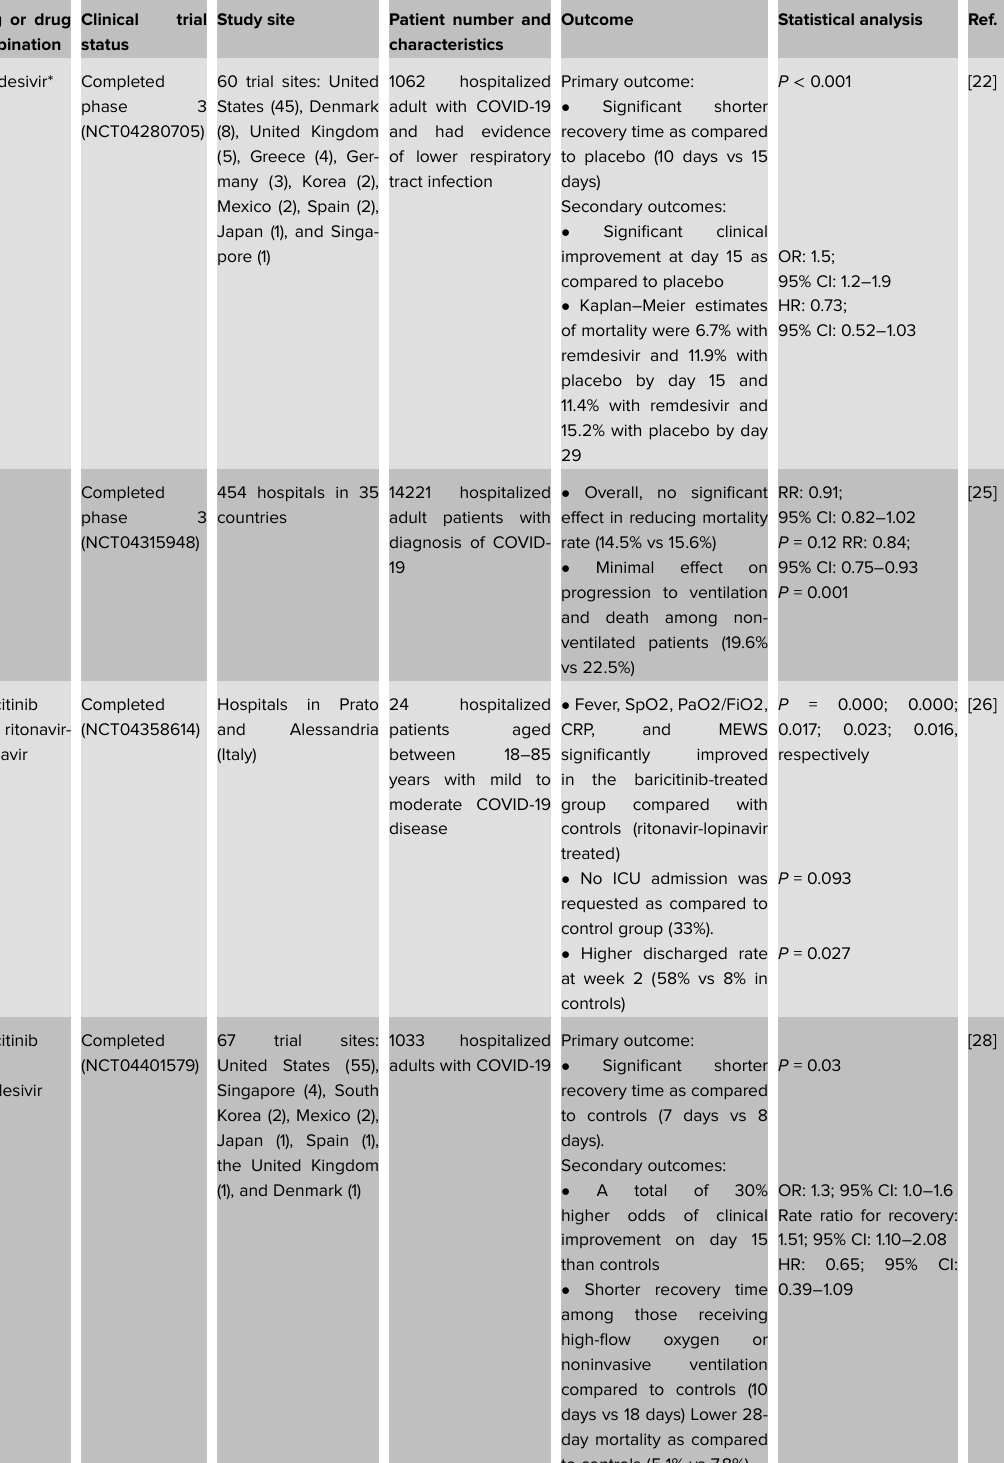
Table 2: Clinical trials of repurposed drugs for the treatment of